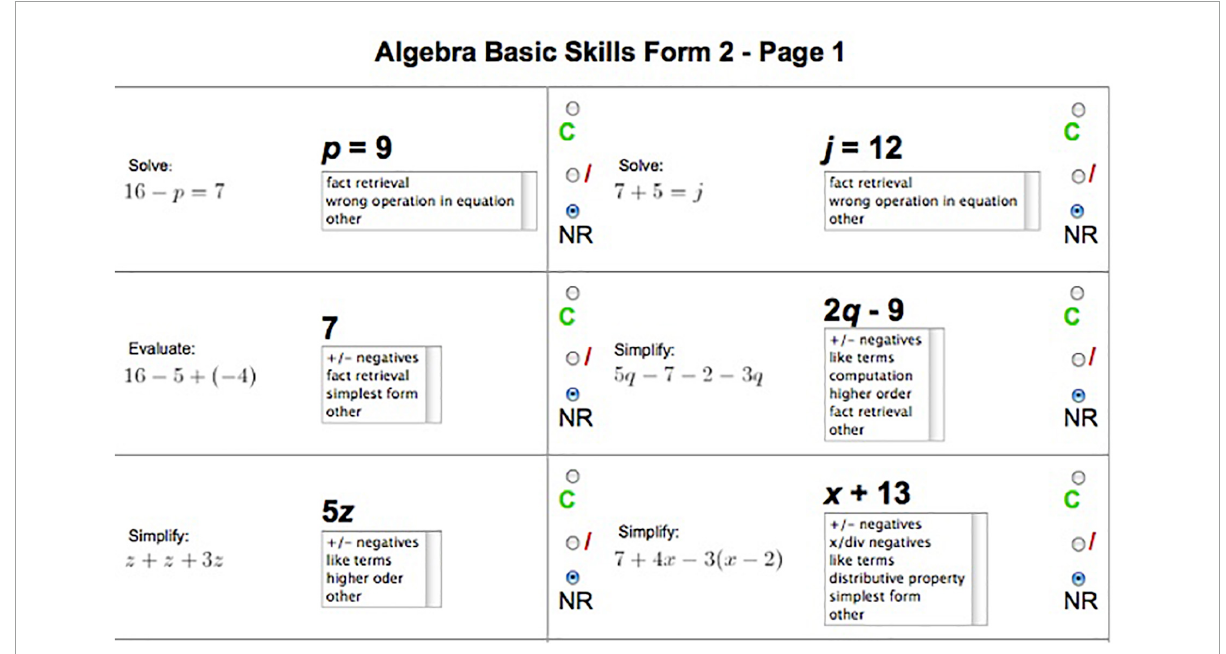
FIGURE2 Sample item-level scoring and drop-down menu of common errors.